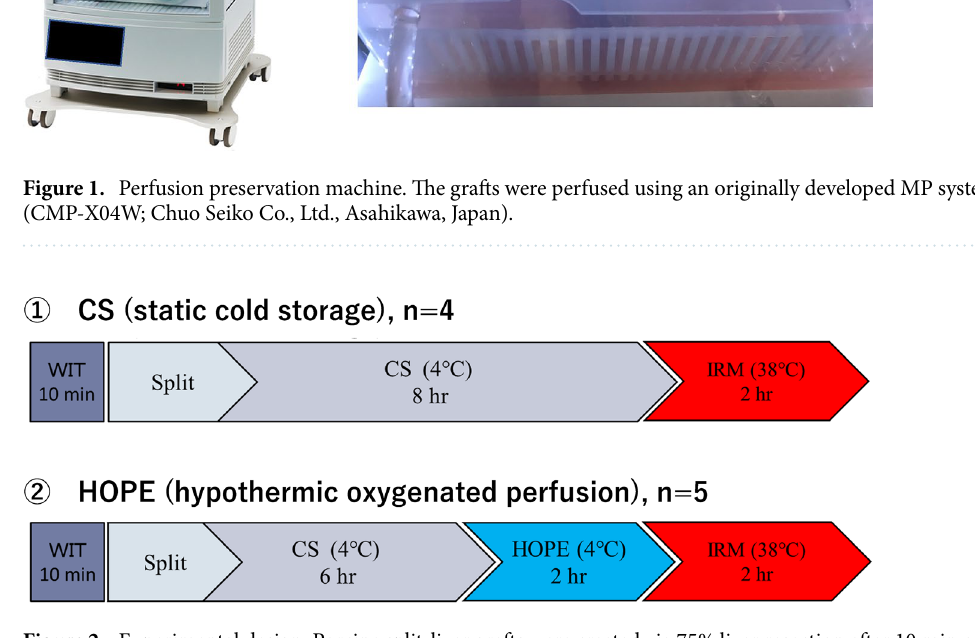
Figure 2. Experimental design. Porcine split-liver grafts were created via 75% liver resection after 10 min of warm ischemia. In Group 1, grafts were preserved by simple CS for 8 h (CS group; n = 4). In Group 2, grafts were preserved by simple CS for 6 h and end-ischemic HOPE for 2 h (HOPE group; n = 5). All grafts were evaluated using an isolated ERM with autologous blood for 2 h. CS cold storage, ERM ex vivo reperfusion model, HOPE hypothermic oxygenated machine perfusion